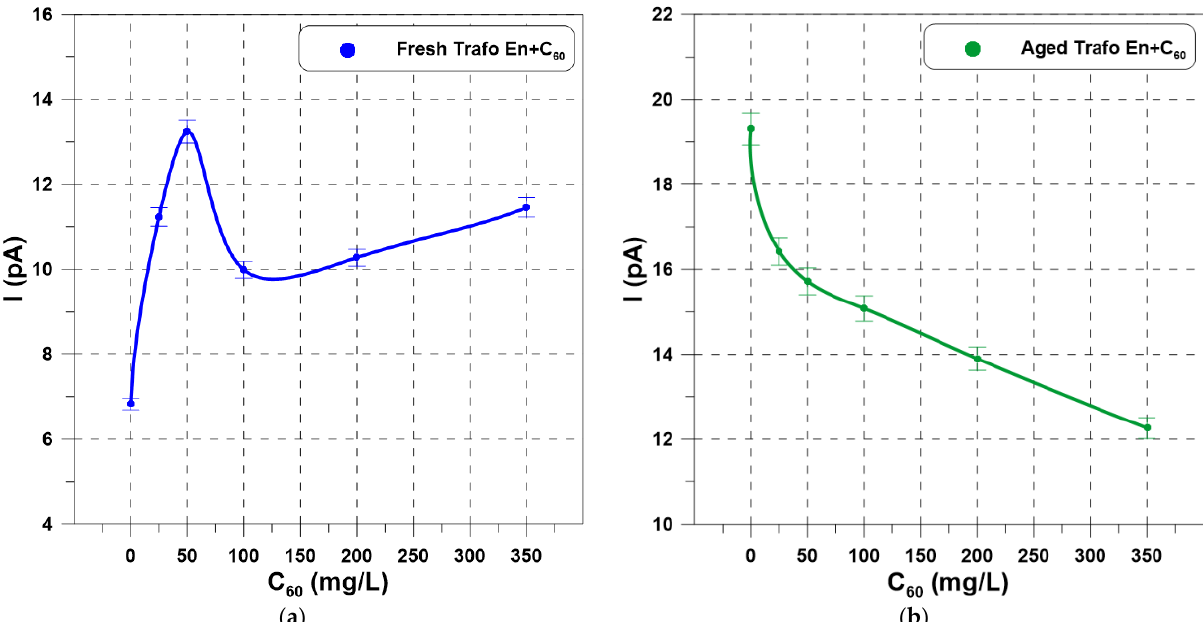
Figure 5. Electrification current of ( a ) fresh and ( b ) aged Trafo En mineral oil versus concentration of C 60 ( v = 0.34 m/s, T = 20 °C).